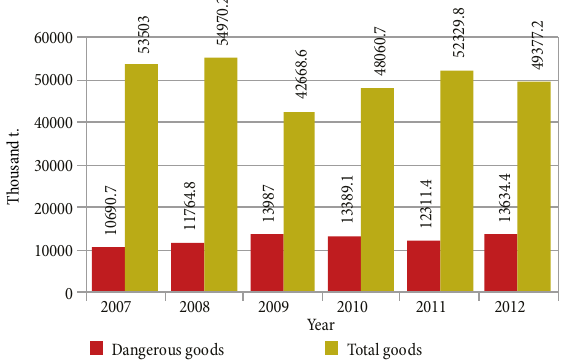
Fig. 1. A comparison of the number of dangerous goods with the total number of goods (Statistics Lithuania